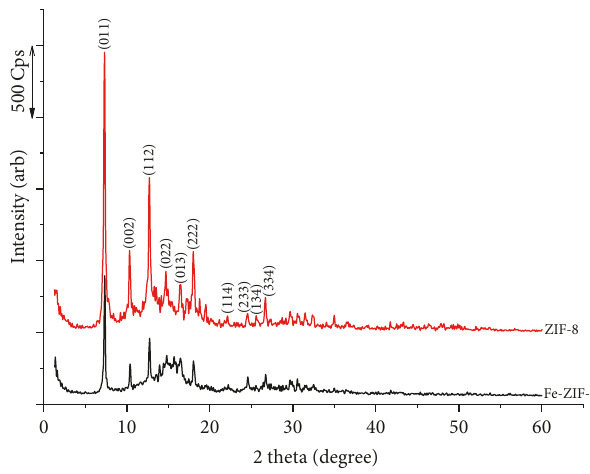
Figure 1: XRD patterns of ZIF-8 and